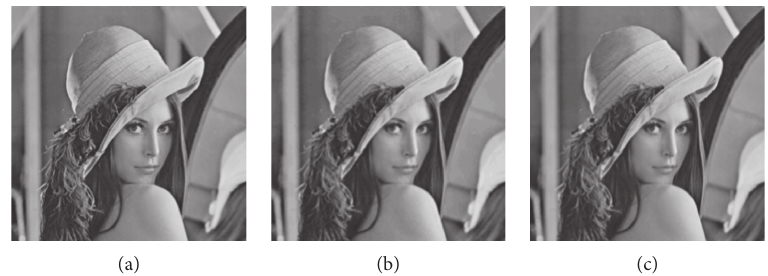
Figure 10: (a) Eight-bit grayscale original image of 256 × 256 pixels in size; (b) images reconstructed using bitplanes 5, 6, 7, and 8; and (c) image reconstructed using bitplanes 6, 7, and